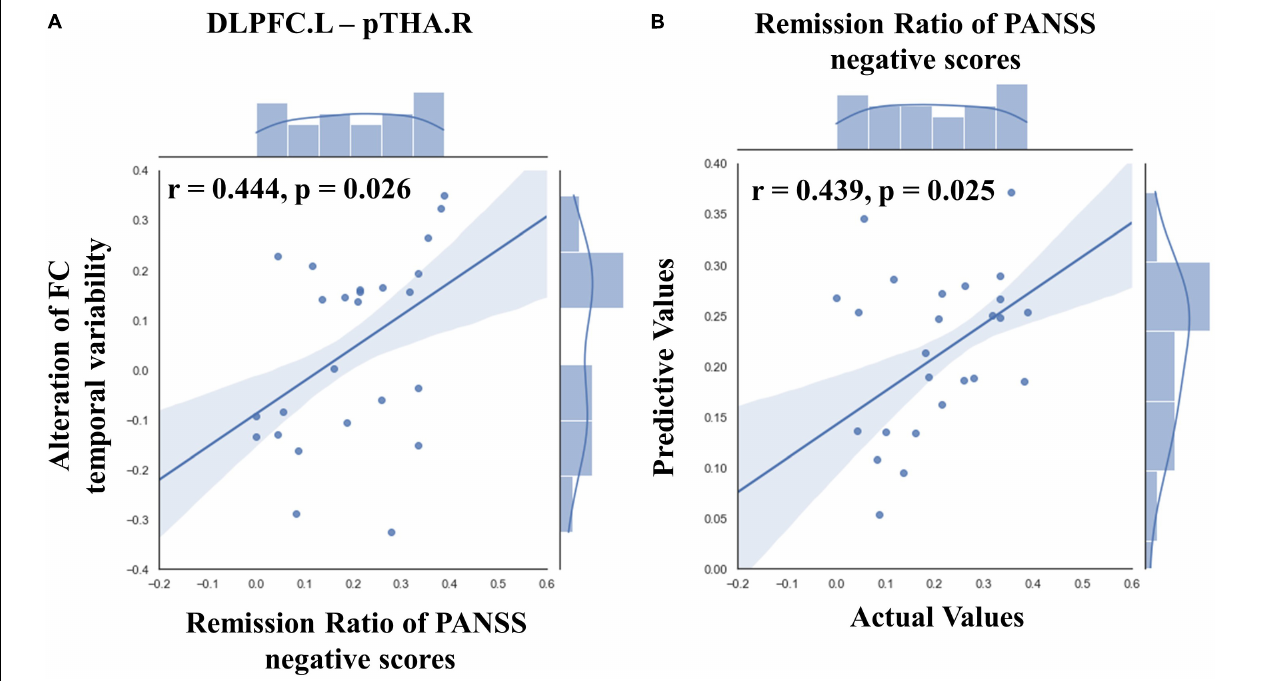
FIGURE 4 | Results of ROI-wise functional connectivity (FC) temporal variability correlation analysis and prediction results of SVR in TSZ group. (A) The correlation analysis showed that the alteration in FC temporal variability between left DLPFC and right posterior parietal thalamus was significantly positively correlated with the remission ratio of Positive and Negative Syndrome Scale (PANSS) negative symptom scores. (B) The SVR result revealed a significantly positive relationship between the connection patterns at pre-rTMS intervention and the remission ratio of PANSS negative scores. The best parameters were obtained by grid search method (best C = 1,000, g = 0.01, MSE = 0.021). Values greater than 2 standard deviations were excluded as outliers. PANSS, Positive and Negative Syndrome Scale; DLPFC.L, left dorsolateral prefrontal cortex; pTHA.R, right posterior parietal